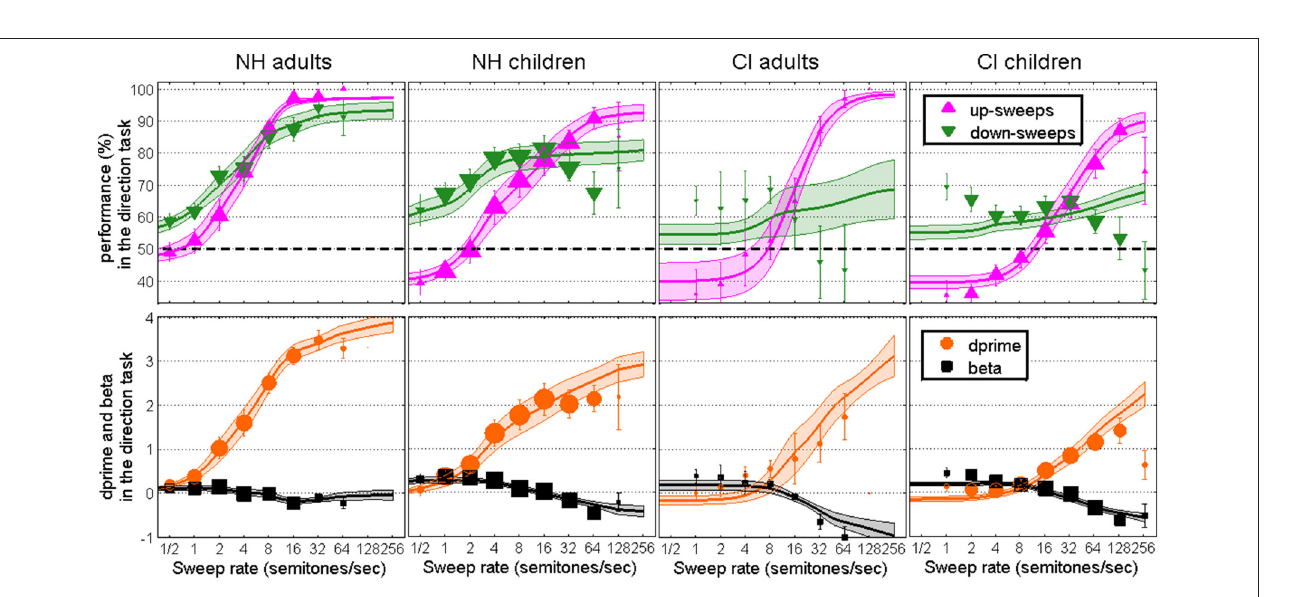
FIGURE 2 | Same as Figure 1 in the 1I-2AFC task of F0 sweep